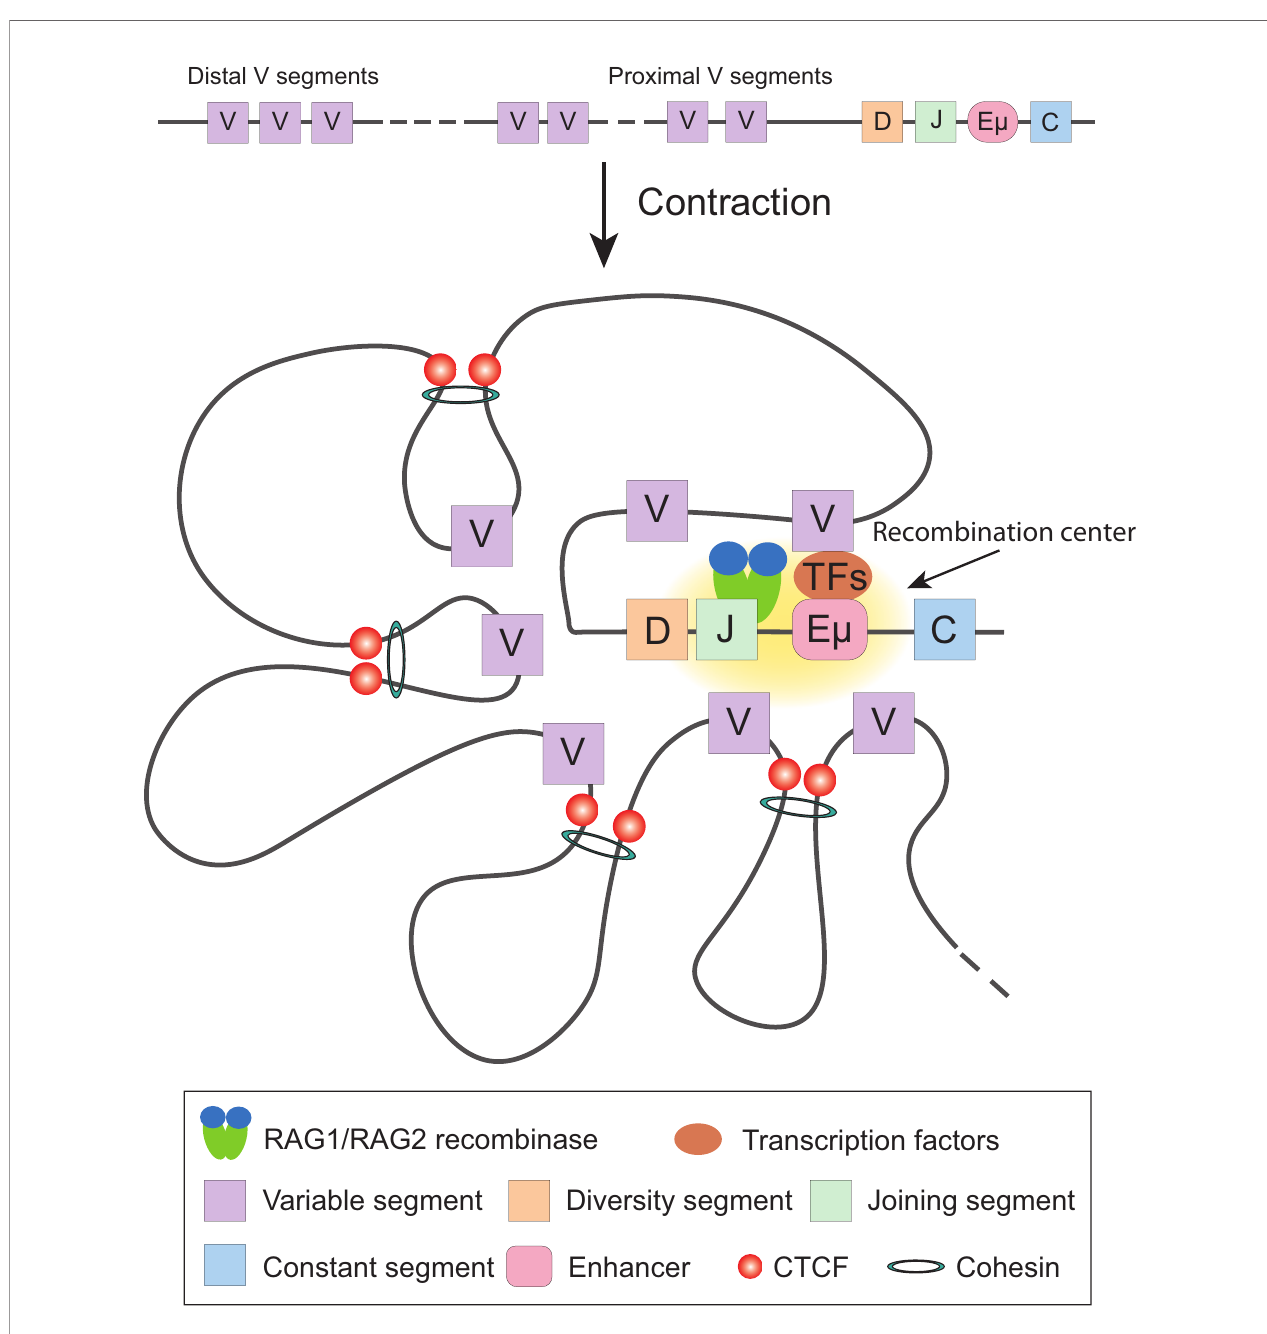
FIGURE 3 | V(D)J recombination of Igh locus. Transcription factors target Enhancer µ and recruit RAG1/RAG2 recombinase to execute recombination. In committed pro-B cells, Cohesin complex and CTCF facilitate Igh locus contraction by looping, ensuring each V gene segment has equal opportunity to target DJ